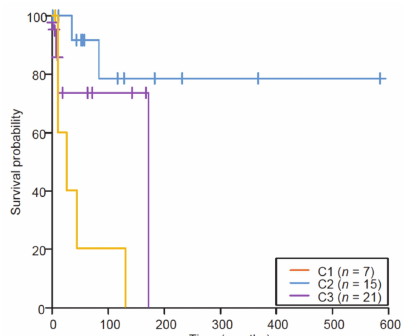
Figure 2. Kaplan–Meier survival analysis of the retrospective series of primary diagnosed ESS stratified by the clusters (log-rank, p = 0.004; Wilcoxon); x-axis, time in months. The three subgroups display di ff erent gene signatures and di ff erent in silico cell cycle scores that significantly correlated with di ff erent overall